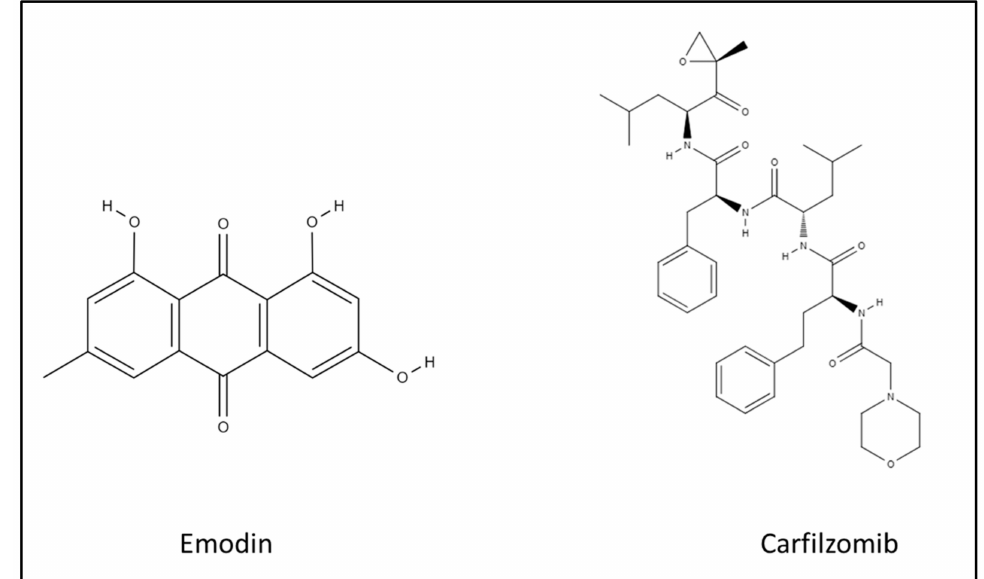
Figure 1. The structure of emodin and